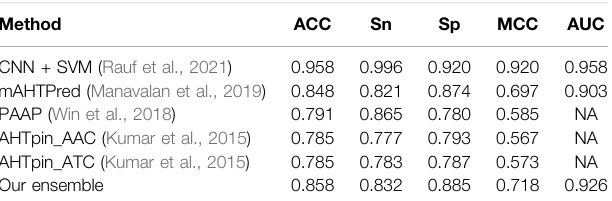
TABLE 4 | Performance evaluation of the proposed method using independence testing